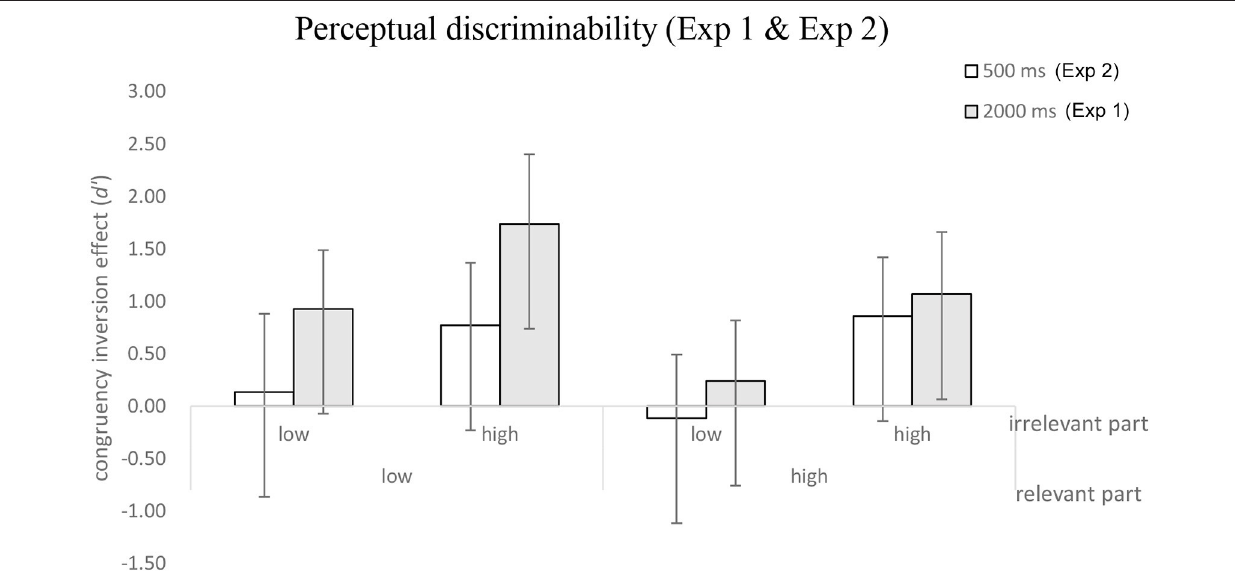
FIGURE 8 | The mean of the congruency inversion effect ( d ’) as a function of exposure (Experiments 1 and 2) and perceptual discriminability of the relevant and irrelevant parts. Error bars indicate 95% confidence interval, calculated within